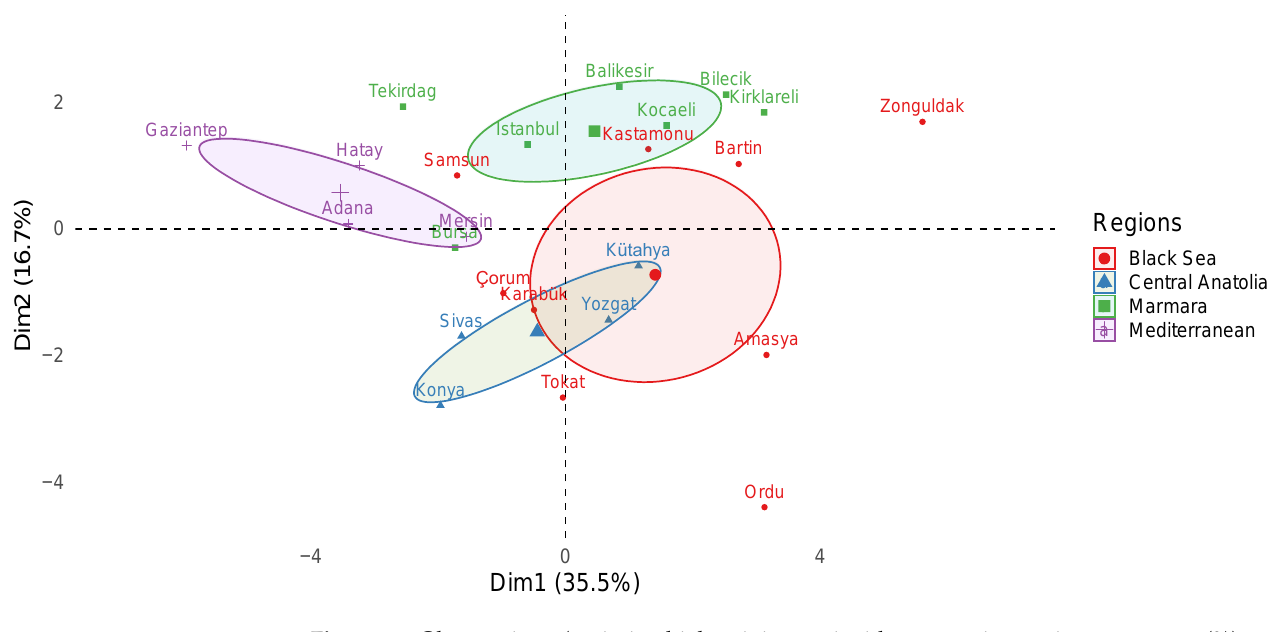
Figure 3. Observations (antimicrobial activity, antioxidant capacity, moisture content (%), and individual phenolic constituents) and PCs belong to Anatolian propolis.